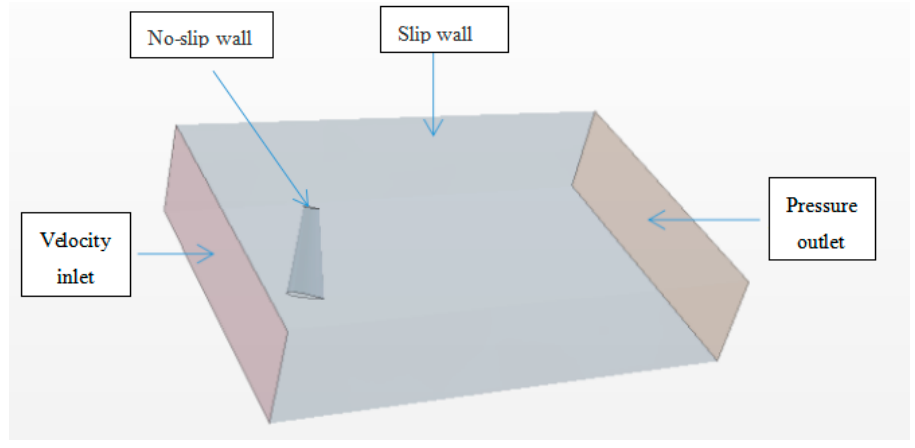
Figure 4. Computational domain and boundary conditions. Results of the grid independence test are shown in Table 2. Taking the experimental value at the angle of attack of 12 ◦ as a reference, three different sets of grids were established, with M1 grids of 2.18 million (base size of 0.028 m), M2 grids of 4.6 million (base size of 0.02 m) and M3 grids of 5.24 million (base size of 0.014 m). As shown in Table 2, both the lift and drag coefficients seem to be insensitive to the mesh sizes. The relative difference between the result using M2 and that using M3 is 0.4% and 0.44% for the lift and drag, respectively. Thus, M2 is selected for the subsequent simulation. The convergence investigation is also considered for other cases with tubercles in different attack angles. All cases suggested that the present mesh configuration with a base size of 0.02 is sufficient to achieve convergent